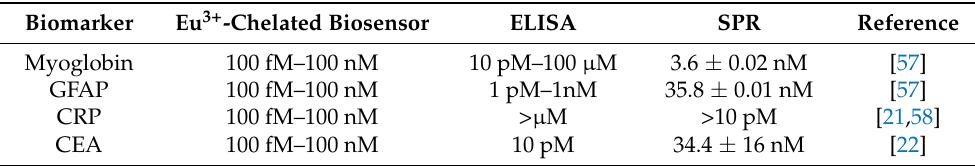
Table 2. Showing comparison between the Eu 3+ chelated biosensor detection range and other biosensor